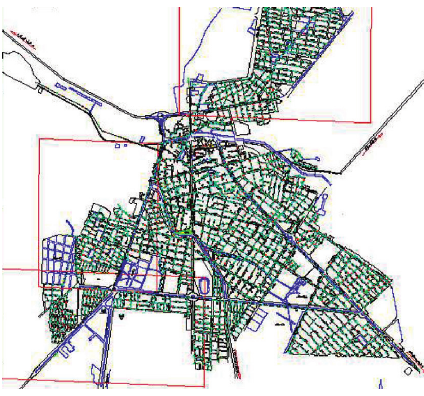
Figure 19: The organization map of the urban wastewater system.